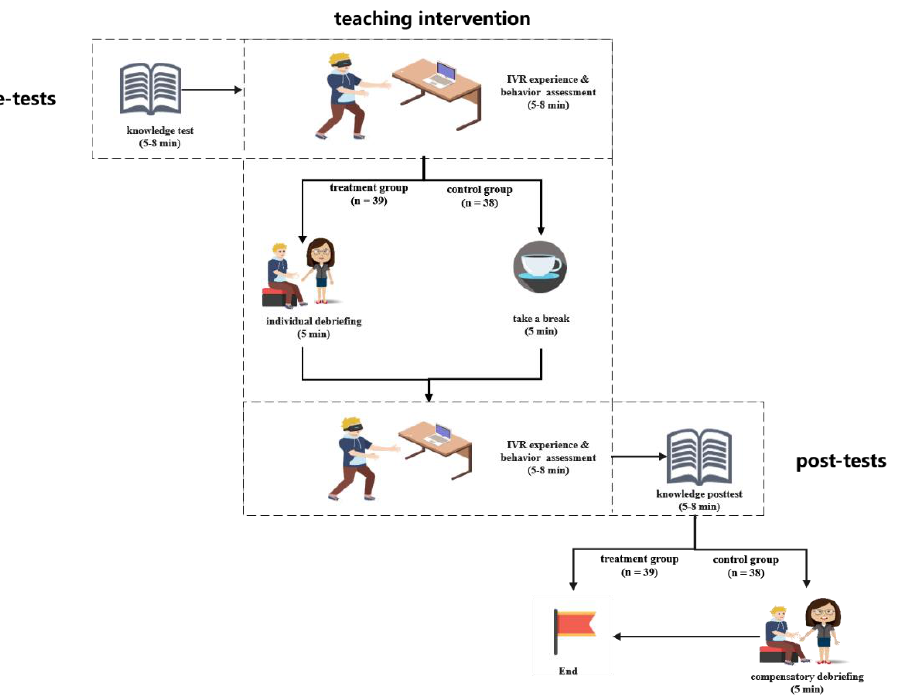
Figure 3. The general procedure of the experimental design.